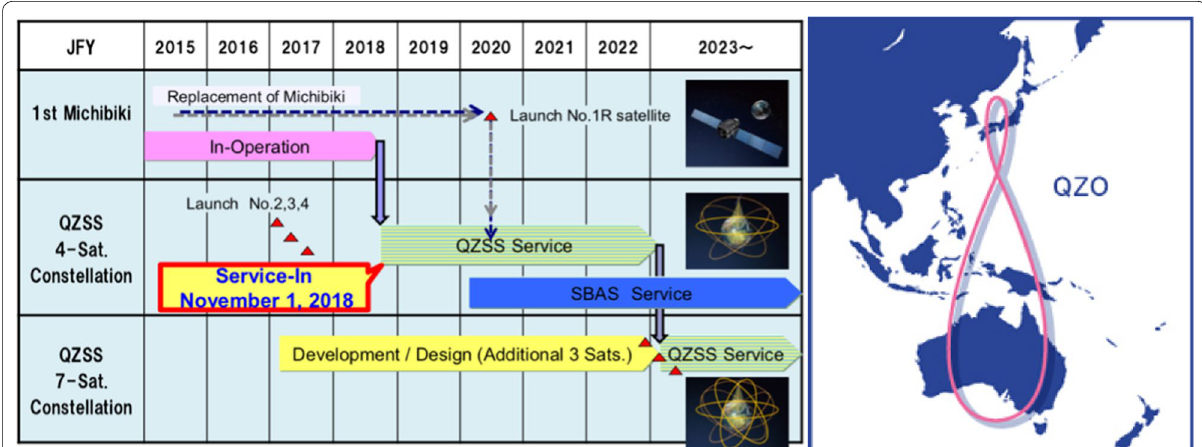
Fig. 4 The Japanese Quasi-Zenith Satellite System (QZSS)—Reference: http://qzss.go.jp/en/